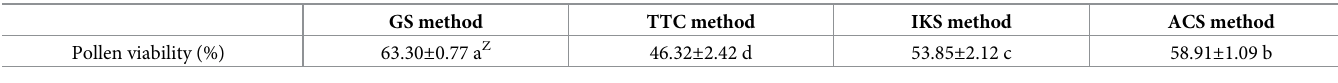
Table 5. Pollen viabilities of ‘Hang Baishao’ based on the different